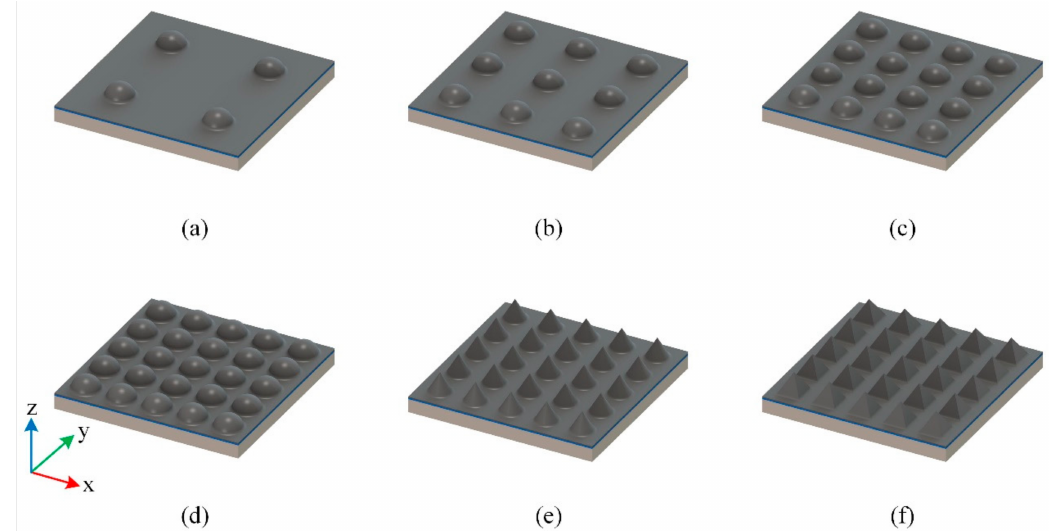
Figure 2. Schematic diagram of the designed sensors with 6 different structures: ( a ) 2 × 2 hemispheres; ( b ) 3 × 3 hemispheres; ( c ) 4 × 4 hemispheres; ( d ) 5 × 5 hemispheres; ( e ) 5 × 5 cones; ( f ) 5 × 5